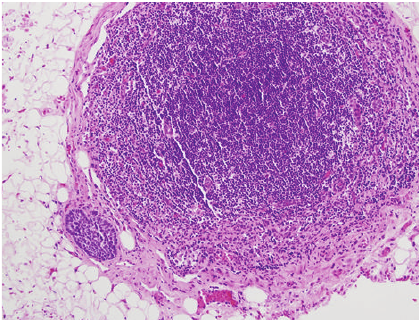
Figure 3: Metastatic granulosa cell tumor in an interaortocaval lymph node. A tumor nest is present in the subcapsular space of an interaortocaval lymph node. The neoplastic cells have scant cyto- plasm and oval nuclei with conspicuous longitudinal groves, con- sistent with the patient’s known primary testicular granulosa cell